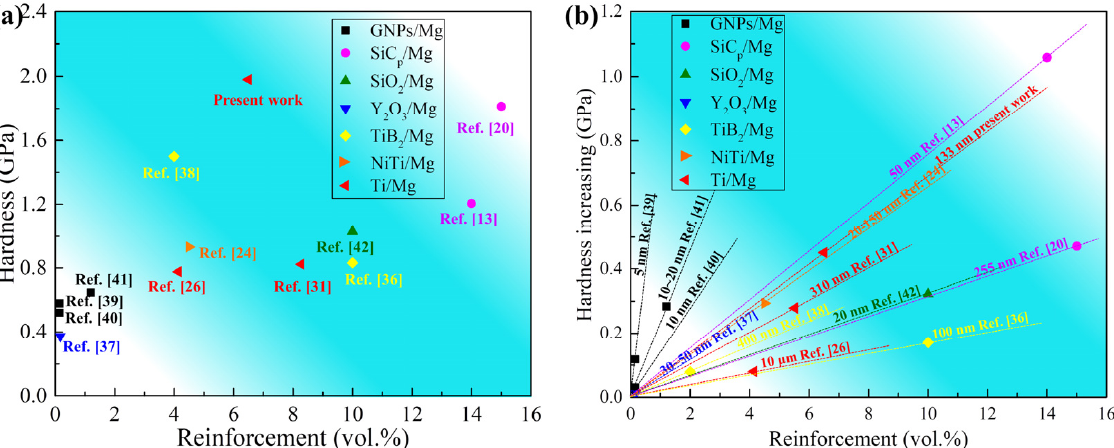
Figure 12. Hardness ( a ) and increasing harness ( b ) of MMCs reinforced by various particles [13,20,24,26,31,36–42]. E SiCp